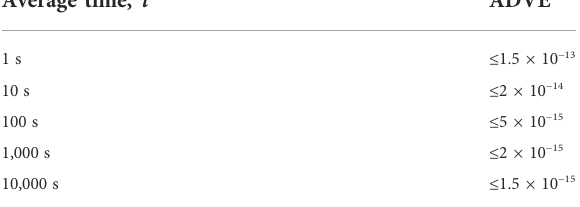
TABLE 1 Stability performance of the MHM-2020 active H-maser. Average time, τ